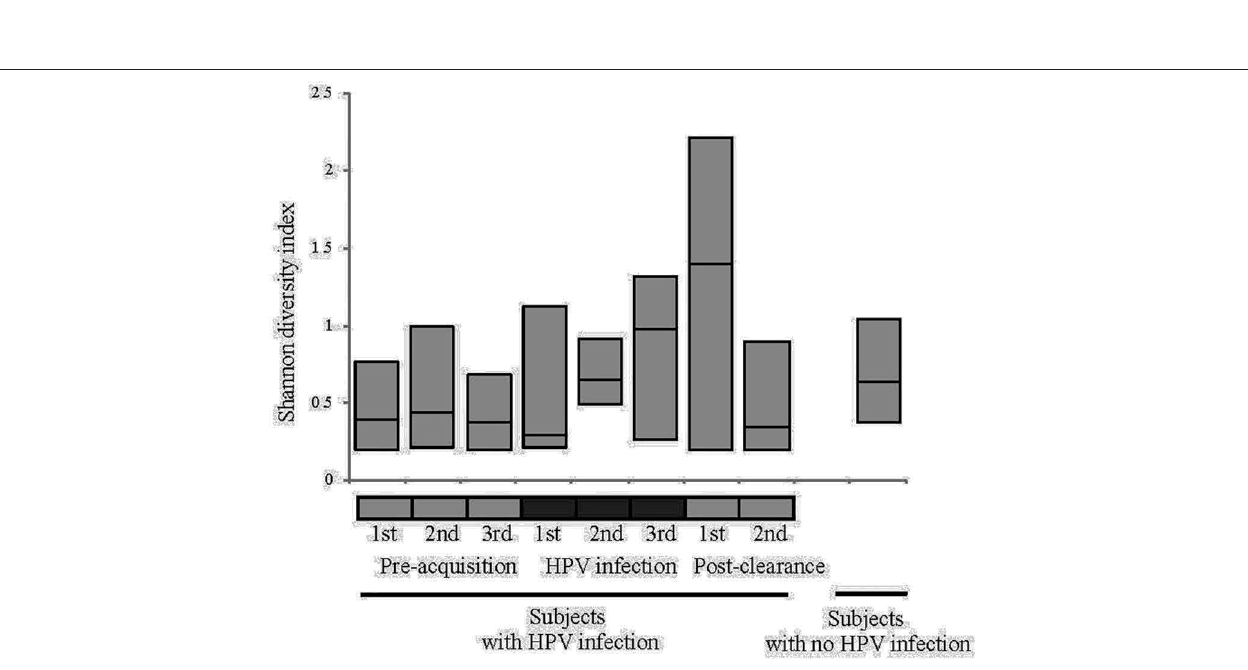
FIGURE 2 | Alpha diversity measured by Shannon index of the microbiome in different HPV states. See Figure 1 definition for HPV states. No statistical differences in the alpha diversity were observed between HPV states or between HPV states and women with no history of HPV.